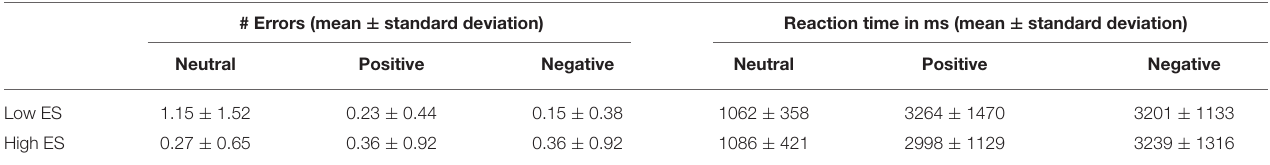
TABLE 2 | Behavioral data obtained during the fMRI experiment: number of stimulus category recognition errors and reaction times for the low and high ES